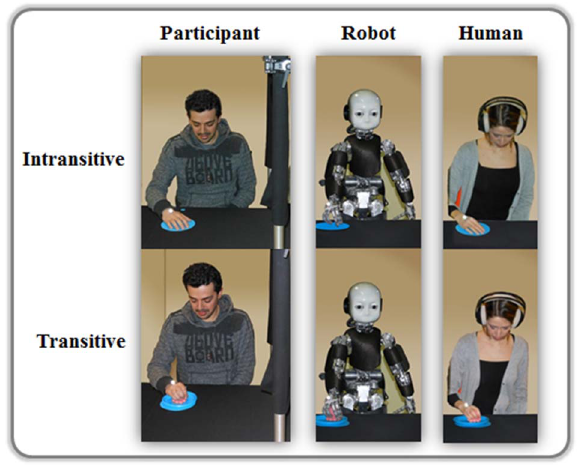
Figure 1. Experimental set up. Participant – on the left side of the black curtain – observed intransitive (upper row) and transitive (lower row) movements performed by the humanoid robot (left column) and by the human demonstrator (right column) –on the right side of the black curtain. In the intransitive condition the model and the participant simply moved the hand from the start to the end position indicated by a blue square and a blue circles, respectively. In the transitive movements the model and the participant moved a pink octopus from the blue square into a final blue toy fishpond. The distance between the start and the final positions was constant.